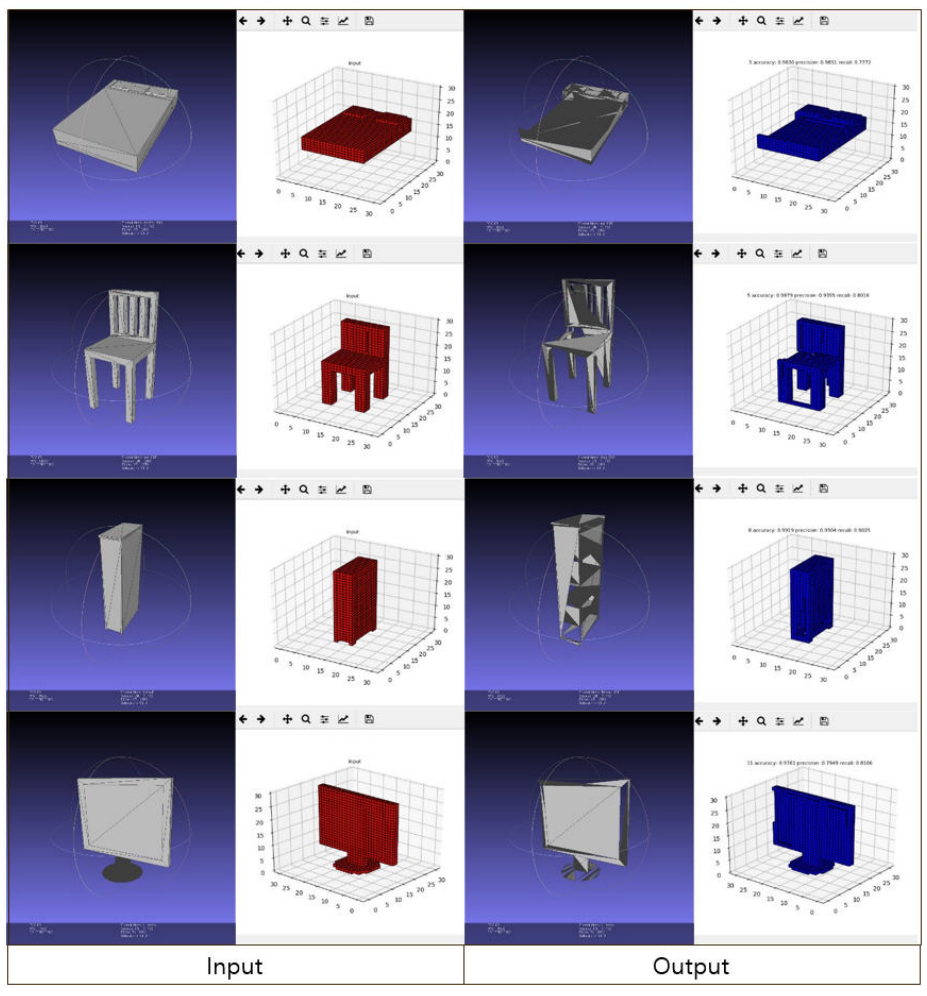
Figure 13. Representation of A V test data